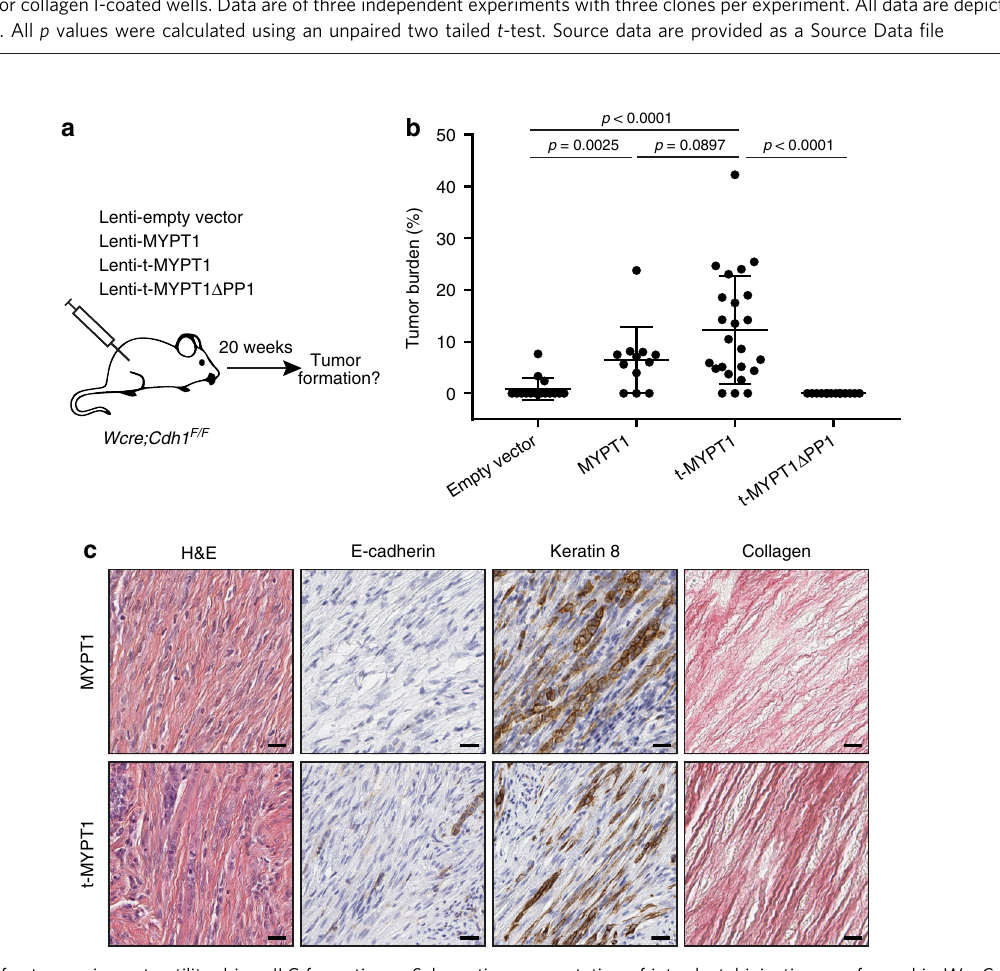
Fig. 6 Collagen I does not support adhesion upon loss of E-cadherin. a IF analysis of GFP (green), Laminin (red), and Keratin 8 (cyan) expression in